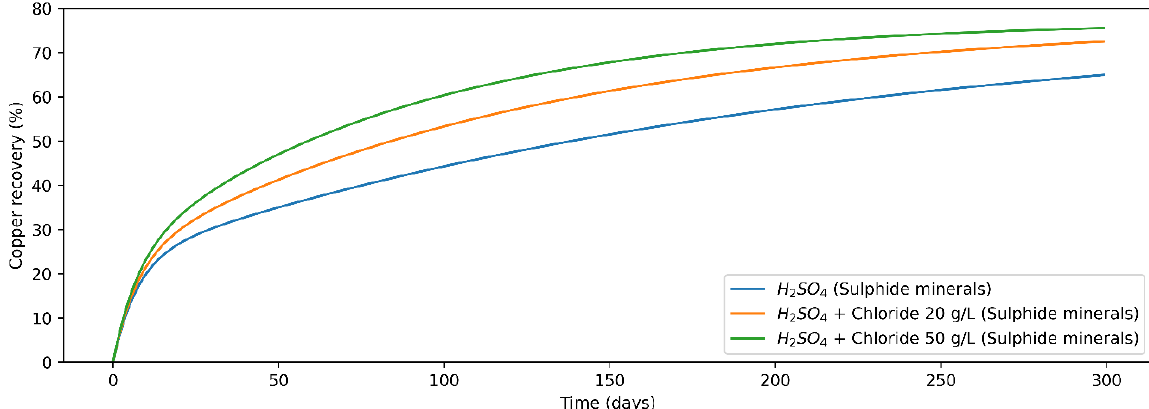
Figure 1. Extraction of copper from sulfide ores in a heap leach using H 2 SO 4 and chloride (modified from: [56]).